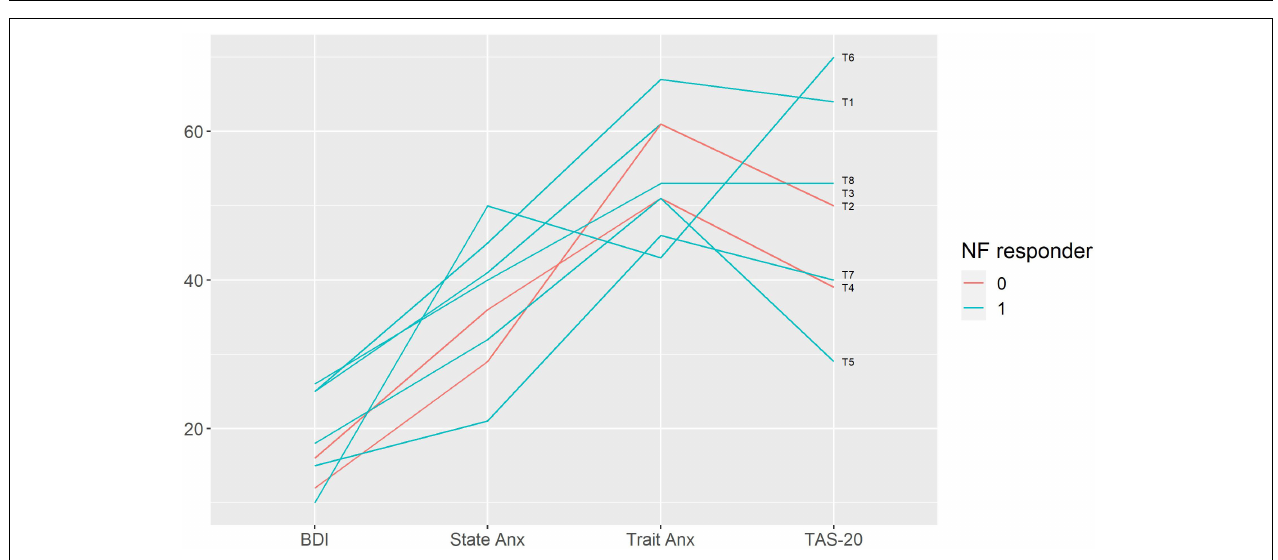
FIGURE 3 | Baseline pain characteristics in participants with and without response to neurofeedback. Each line represents a patient case (indicated on the right end of the line). Neurofeedback responders are show in blue, neurofeedback non-responders — in red color. MHDs — headache frequency, monthly headache days; MPQ — McGill Pain Questionnaire: Sensory (Sens), Affective (Aff), Evaluative (Eval) scores and the Pain Rating Index (PRI); NF — neurofeedback.